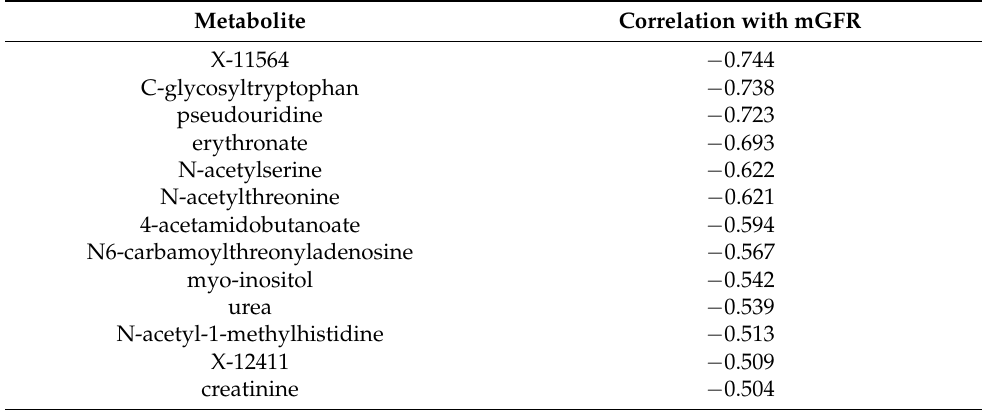
Table 2. Overview of the correlations of several metabolites with mGFR [103]. Metabolite Correlation with